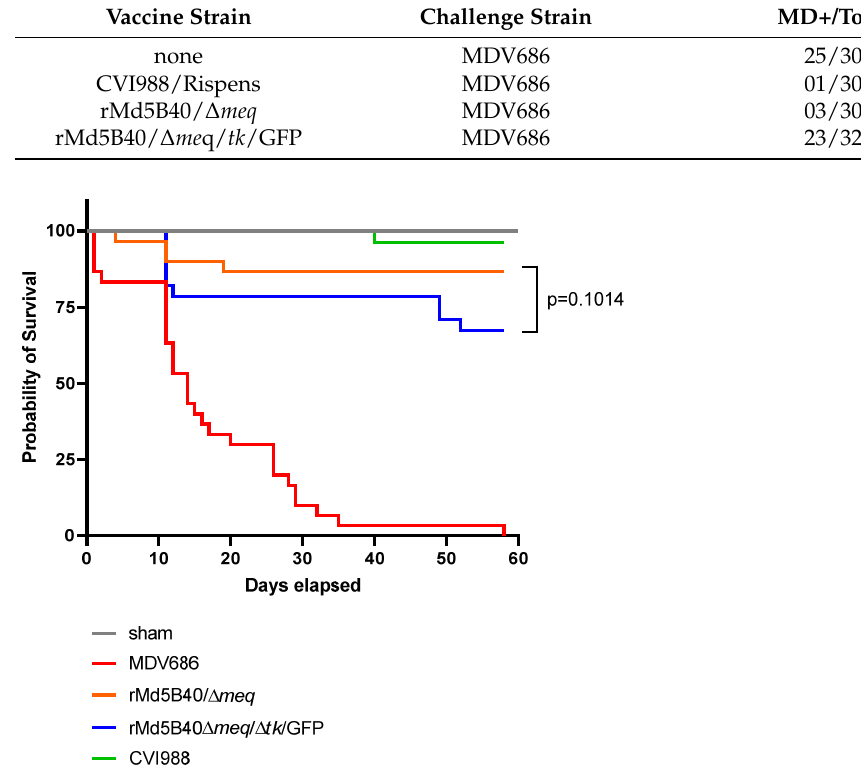
Table 1. Ablation of the viral tk reduces protection against the development of the visceral tumors diagnostic of MD. Birds were scored for the presence of visceral tumors at necropsy. Vaccine Strain